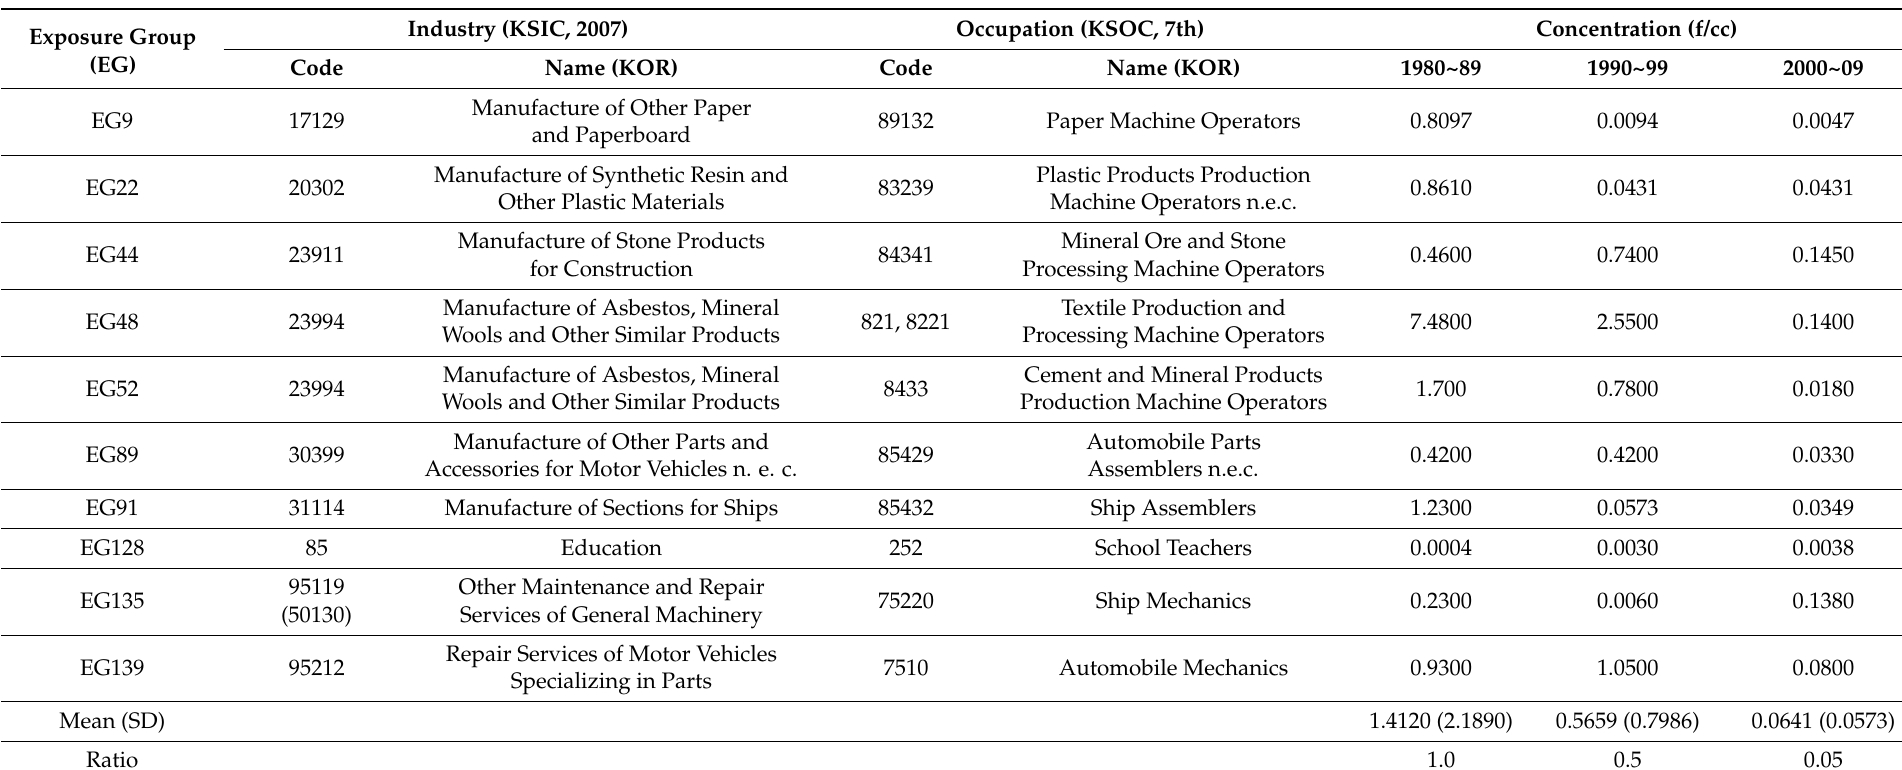
Table 1. Asbestos concentrations of exposure groups without blanks in any of the 3 decades of recent Korean asbestos job-exposure matrix (JEM). Exposure